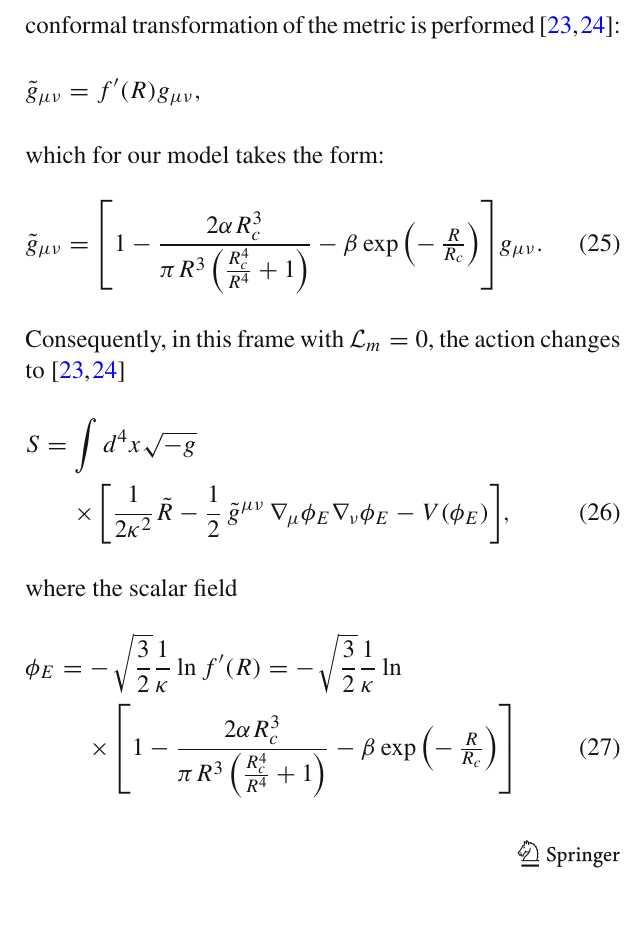
Fig. 2 Variation of the potential (24) as a function of the background curvature R 0 for different sets of values of α and β with R = 1 in arbitrary c